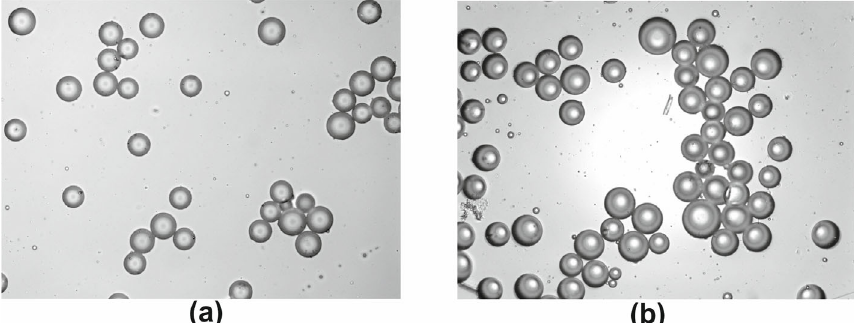
Figure 1. The representative images of EAT adipocytes of patients from groups 1 and 2. ( a ) Patient from the group of patients with non ‐ hypertrophic EAT adipocytes, the median adipocyte diameter of this patient is 85.5 μ m; ( b ) Patient from the group of patients with hypertrophied EAT adipocytes, the median adipocyte diameter of this patient is 90.45 μ m; Light microscopy without staining, magnification × 200; EAT, epicardial adipose tissue.